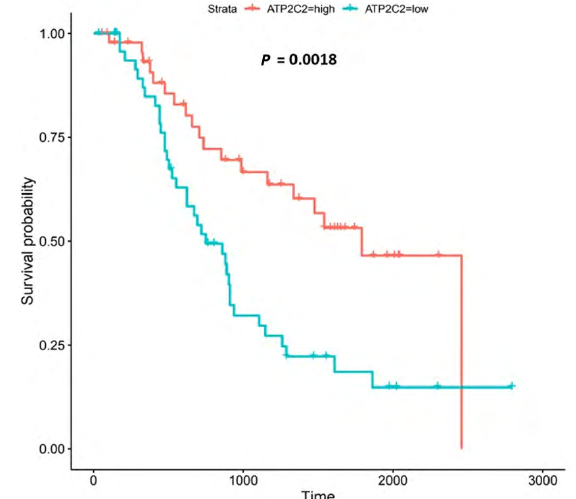
Figure 13. Kaplan-Meier survival plot for ATP2C2 . Details as described in Figure